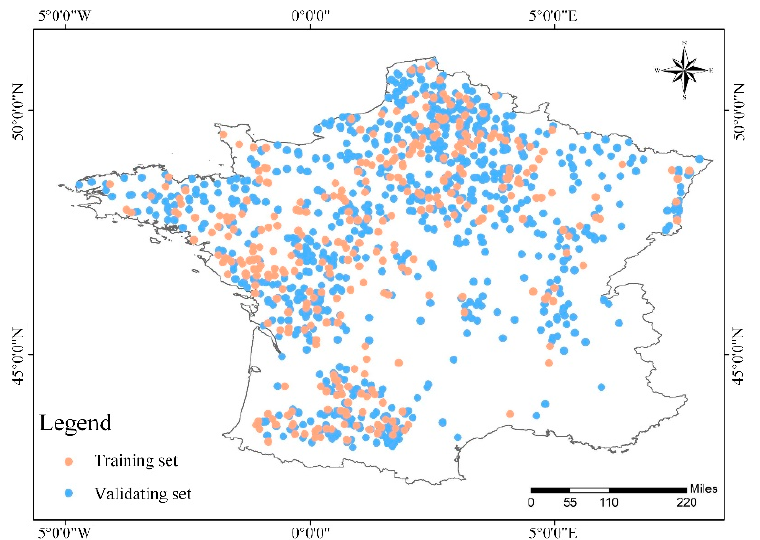
Figure 5. Sample data distribution map.